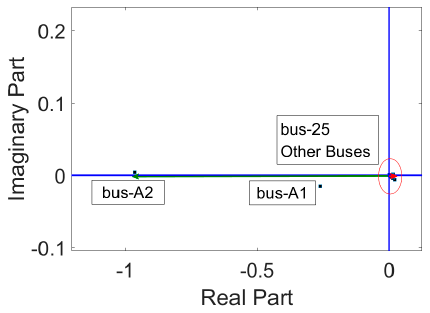
Figure 6. Nodal voltage mode shape of the 29.8 Hz mode in the modified system.